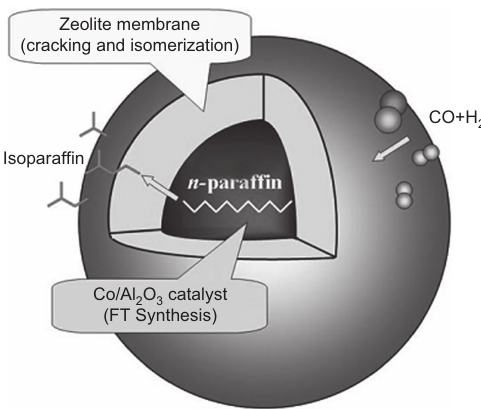
Figure 1 Acidic zeolite coated core-shell structure (Reprinted from ref [27]. Copyright (2008), with permission from John Wiley and